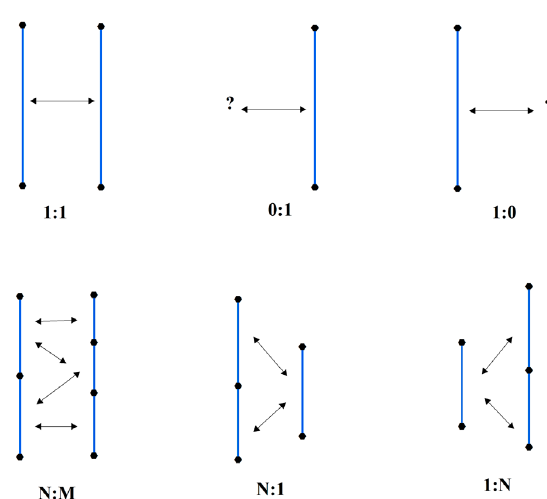
Fig. 3. Matching relations